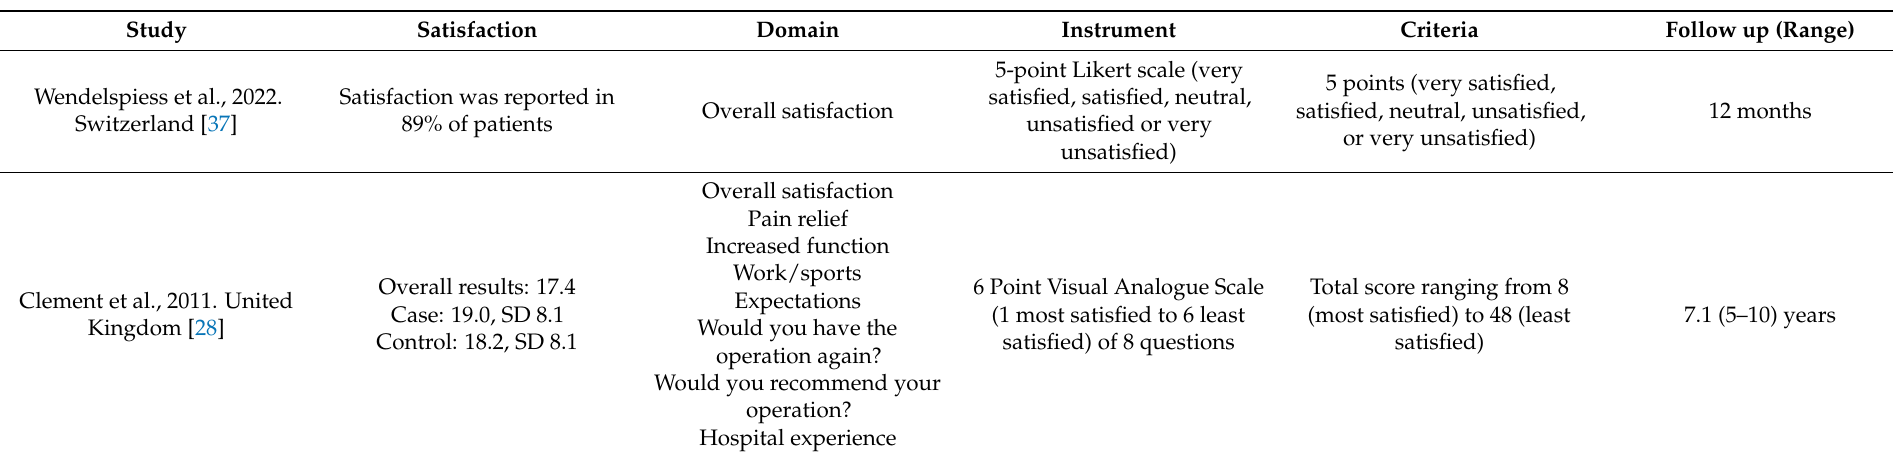
Table 6. Satisfaction with the results of total knee